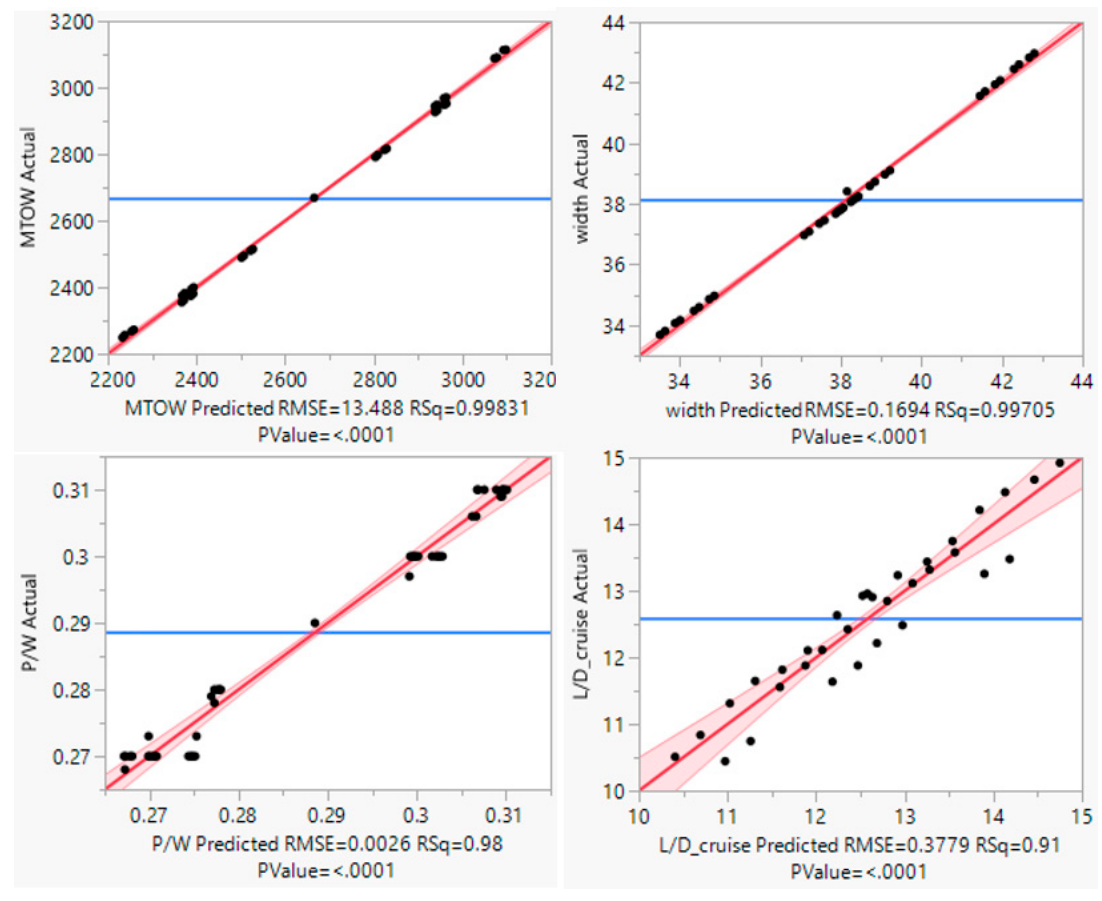
Figure 11. Converting fractional values to design parameter values.